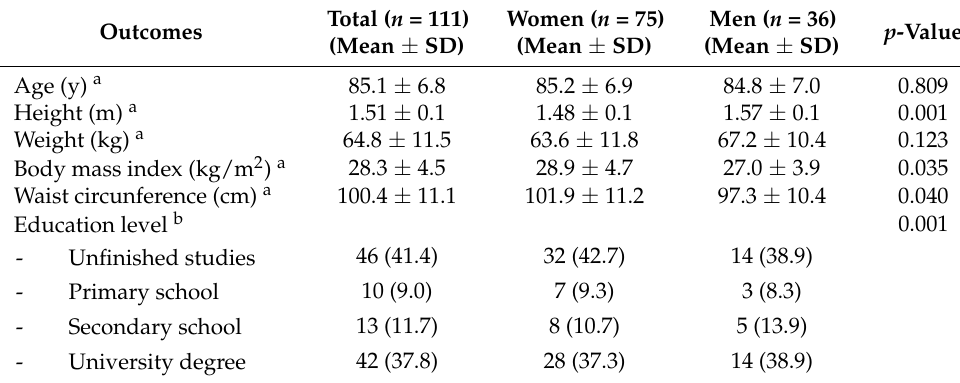
Table 1. Main characteristics of the participants.